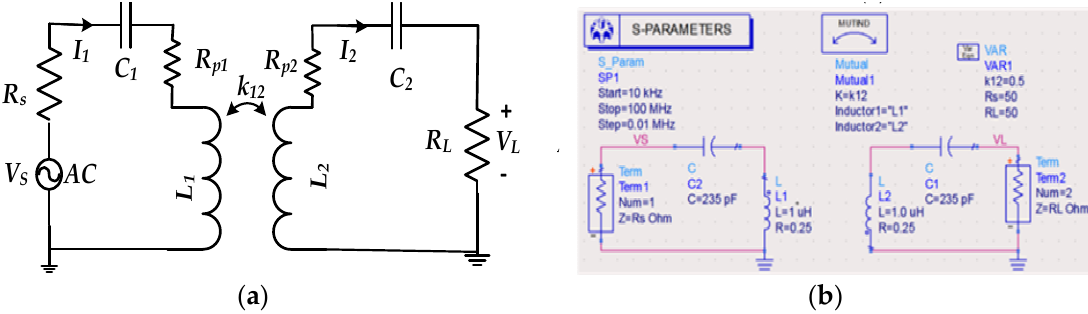
Figure 3. Circuit model of a two-coil WPT system used to characterize the inductively coupled two-coil inductive channel. ( a ) AC simulation setup. ( b ) Two-port S-parameter simulation setup. The simulation results of the power transfer function magnitude, |Hp(f)|, and the sidebands of the modulated baseband data signal are added around the data carrier frequency (i.e., fc = 65 MHz), as shown in Figure 4. The HF sidebands of the spectrum of the modulated signal are located aside from the WPT channel bandwidth, leading to high attenuation of the data signal. The bandwidth of the baseband signal should not exceed the half bandwidth of the resonant inductive channel to reduce the distortion and attention of the HF data signal.